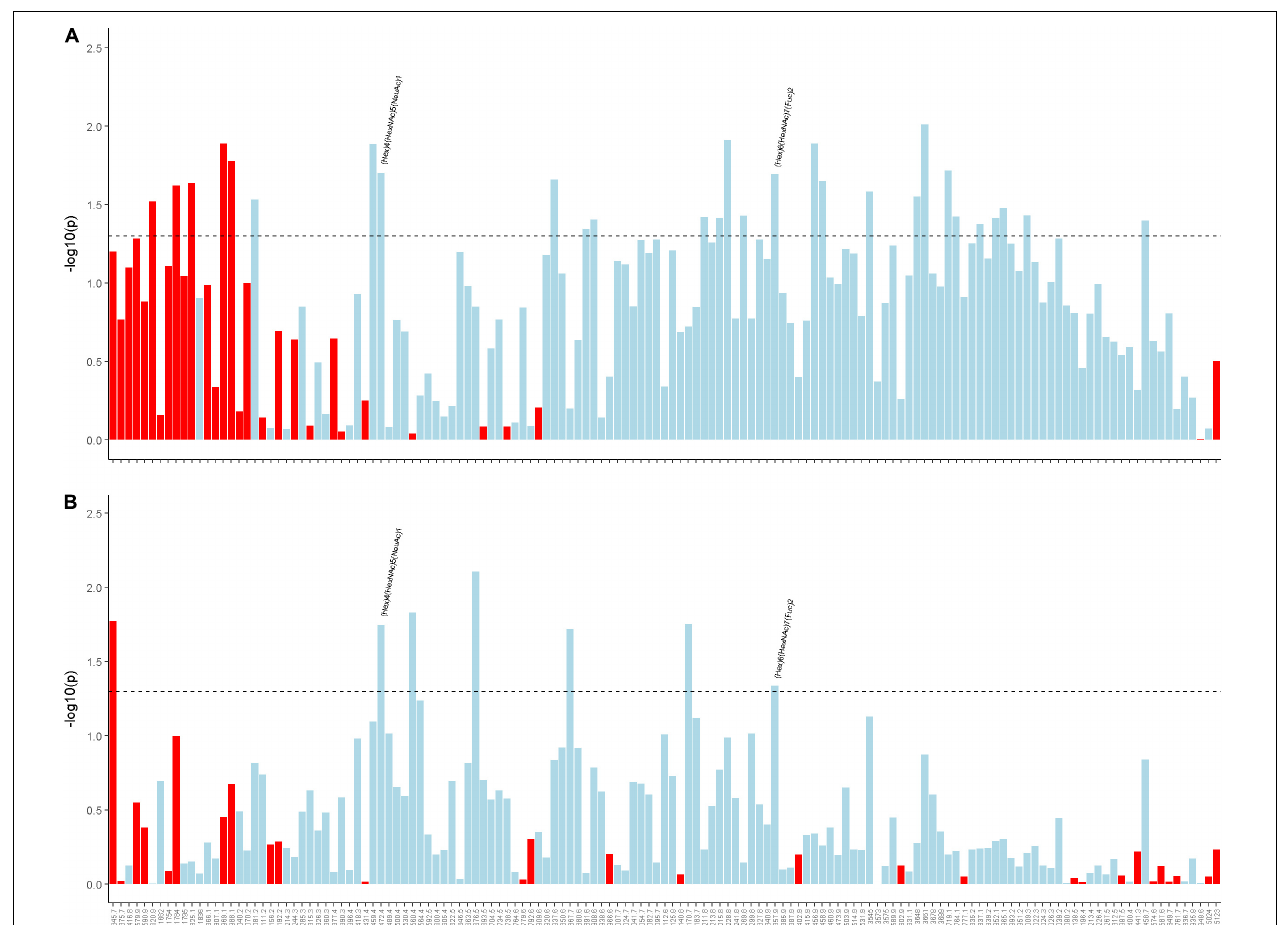
FIGURE 4 | Illustrates the associations of cortical N-glycans with β -amyloid load (A) and PHFtau tangles density (B) . Individual N-glycans are shown as m/z ratios on the x -axis. Statistical significance, represented by –log10 of the p -value, is shown on the y -axis. The horizontal dotted line represent the nominal significance level of α = 0.05. Red indicates a positive direction of association and light blue indicates a negative direction of